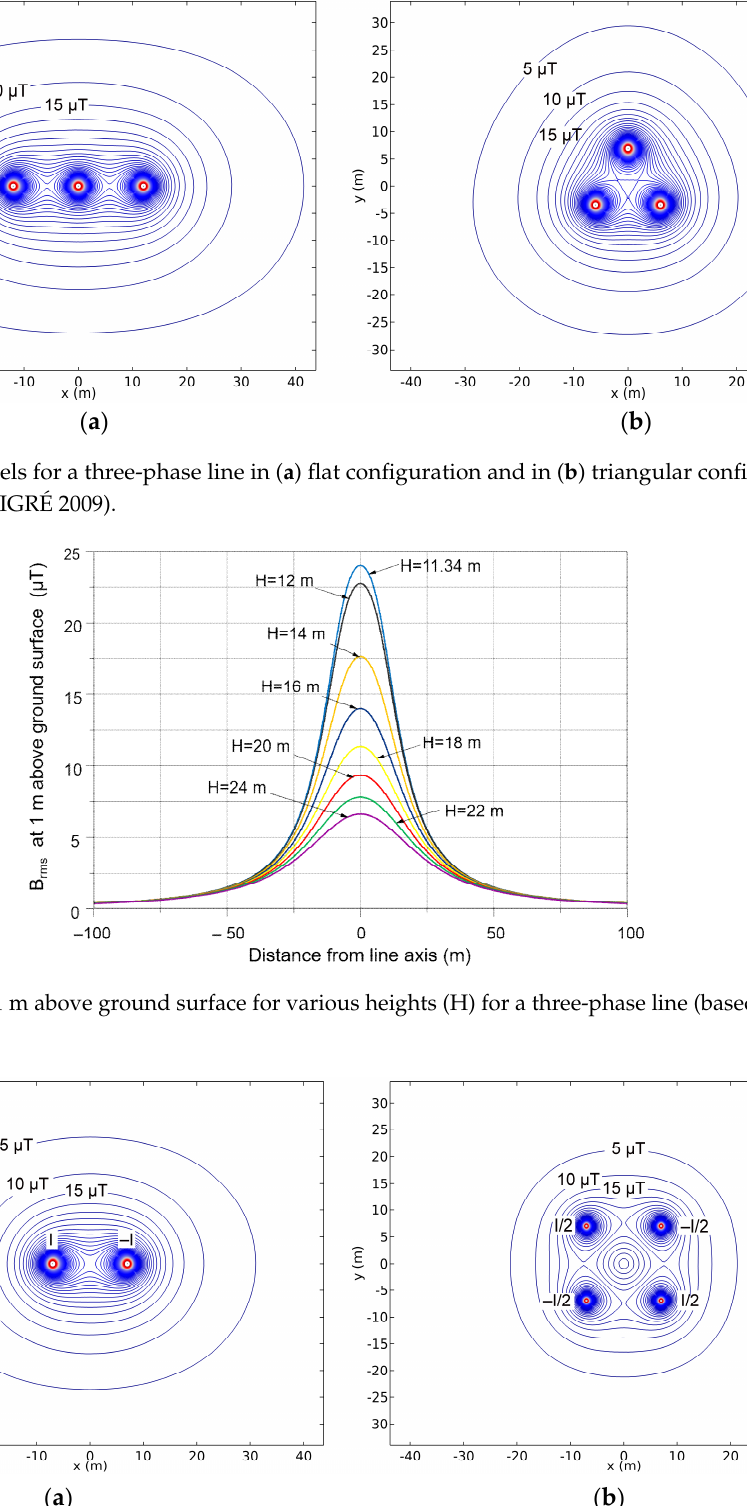
Figure 3. MF levels for a line arranged as a ( a ) dipole and ( b ) a quadrupole line (based on [13], CIGRÉ 2009).